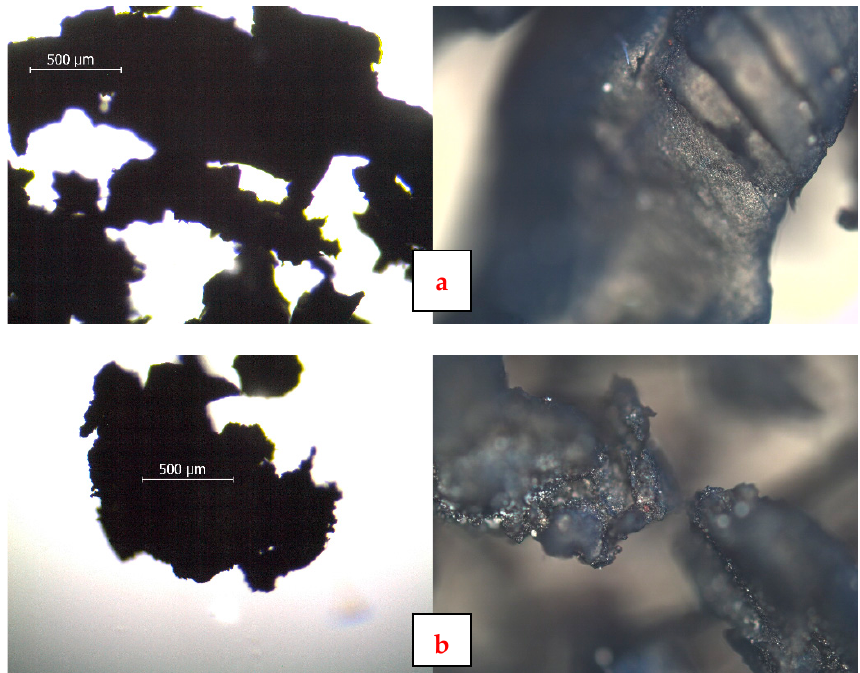
Figure 4. Microscopic photos of CR particles: ( a ) untreated CR particles and ( b ) treated CR particles. On the left we have the scale and on the right the detail.